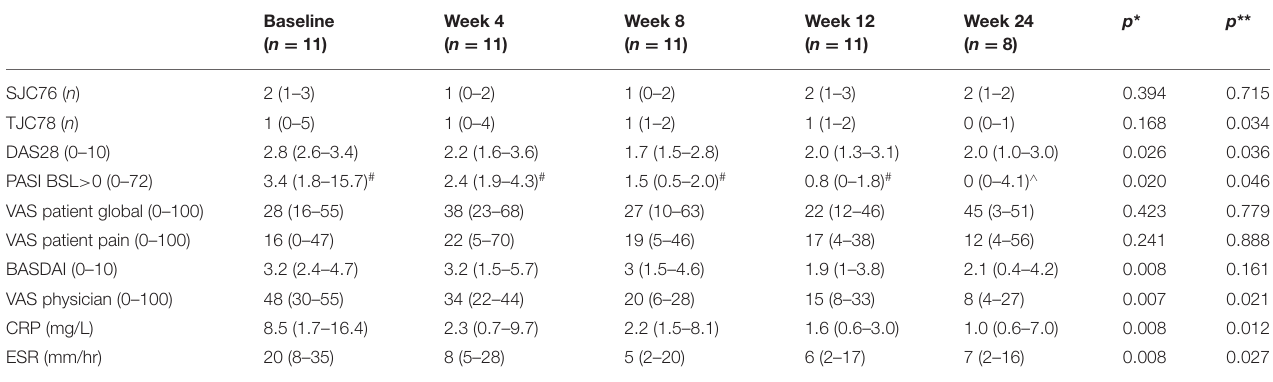
TABLE 1 | Disease activity parameters as observed for the total study